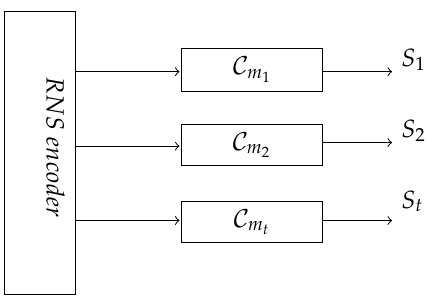
Figure 4. RNS secure circuit’s multi-lane